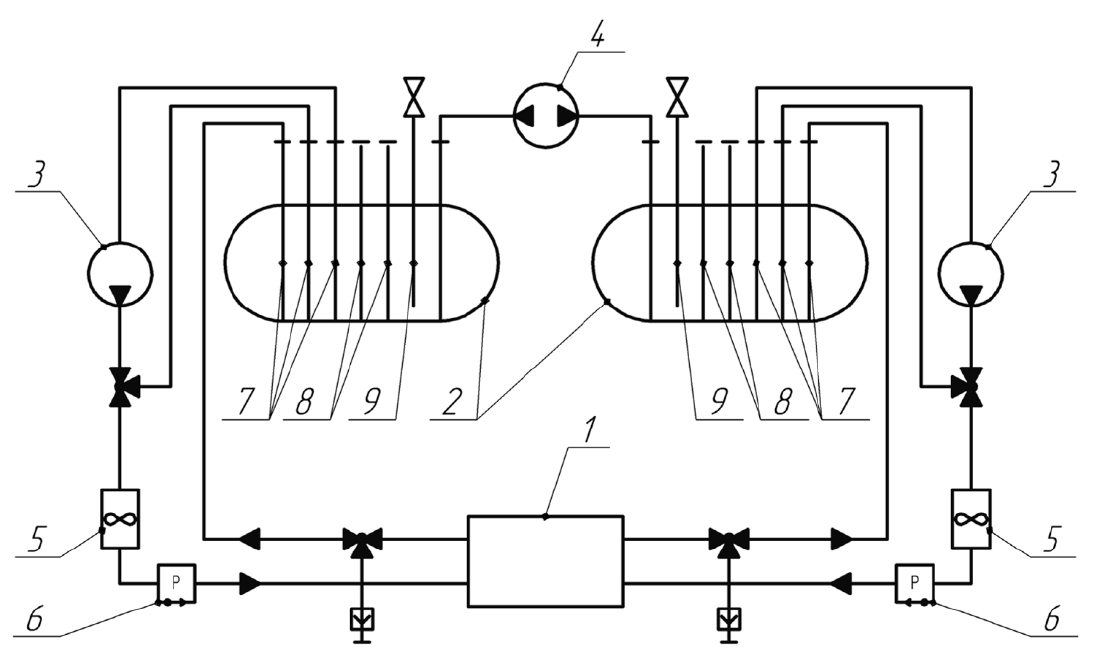
Figure 2. Hydrodynamic scheme of the stand: 1—flow battery stack; 2—tanks with electrolyte; 3—main electrolyte pumps; 4—balancing pump; 5—electrolyte flow sensors; 6—pressure sensors; 7—outlet pipes R-32; 8—branch pipes with an outlet in the form of a fitting; 9—branch pipes KD-10